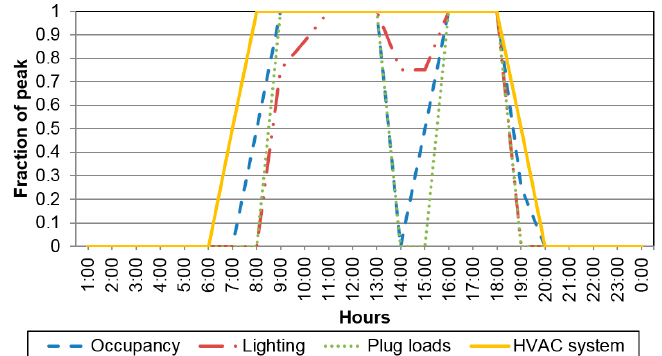
Figure 3. Loads operation schedules in a typical weekday.